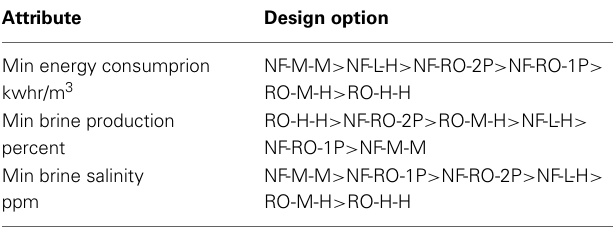
Table 4 | Variability in importance across design options. Attribute